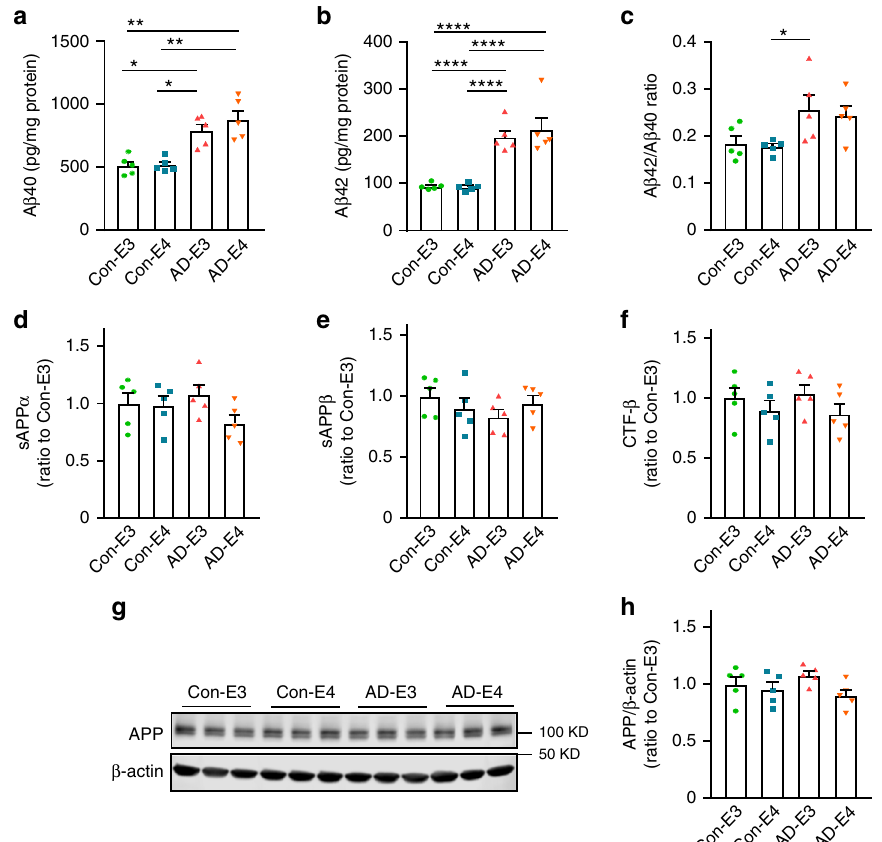
Fig. 3 Increased A β accumulation in iPSC-derived cerebral organoids from AD patients. Lysates of 4 – 5 cerebral organoids per iPSC line were analyzed by ELISA and western blotting at week 12. a – c Amounts of A β 40 ( a ; APOE4: p = 0.2167, AD: p = 0.0002, APOE4 x AD: p = 0.4849, Con-E3 vs. AD-E3: p = 0.0287, Con-E3 vs. AD-E4: p = 0.0028, Con-E4 vs. AD-E3: p = 0.0171, Con-E4 vs. AD-E4: p = 0.0011) and A β 42 ( b ; APOE4: p = 0.1014, AD: p < 0.0001,